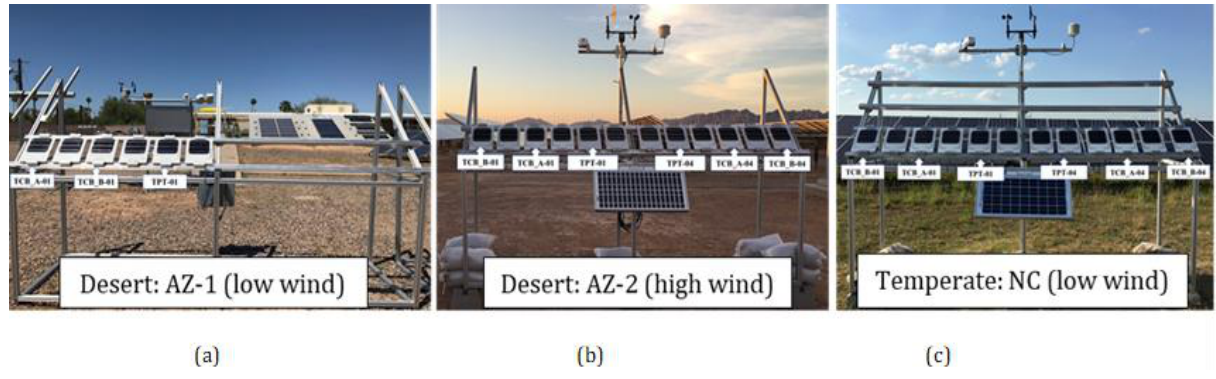
Figure 1. Installation of 30 one-cell modules at three different sites: ( a ) 6 modules at the AZ-1 site, which has a hot-dry desert climate and low wind speed; ( b ) 12 modules at the AZ-2 site, which has a hot-dry desert climate and high wind speed; ( c ) 12 modules at the NC site, which has a temperate climate and low wind speed.